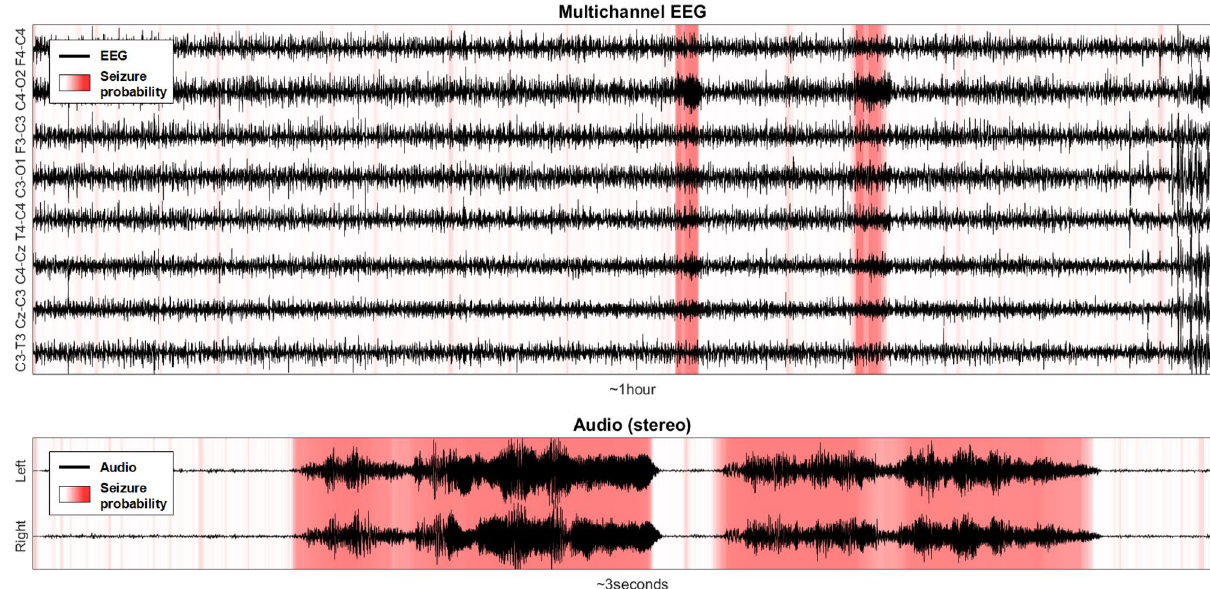
Figure 2. AI-driven sonification algorithm demo (EEG31 in Helsinki dataset). EEG is converted into audio and compressed non-uniformly in time as function of the seizure probability given by an AI algorithm (best seen in